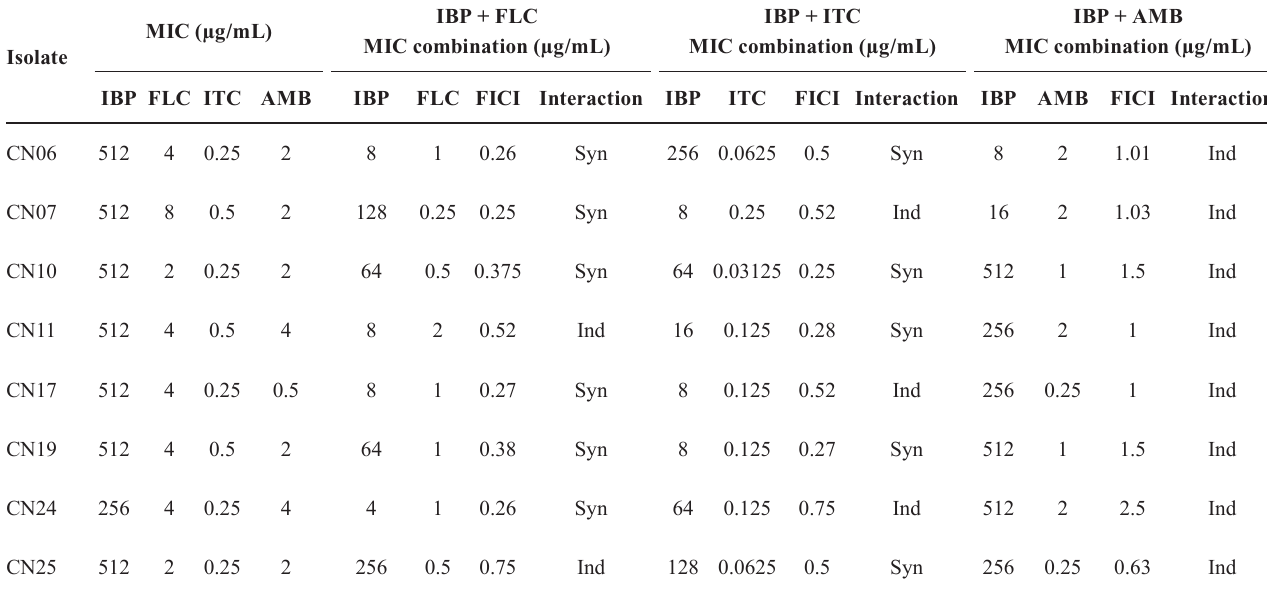
TABLE II - In vitro susceptibility of Cryptococcus neoformans to ibuprofen (IBR) combined with itraconazole (ITC), fluconazole (FLC) and amphotericin B